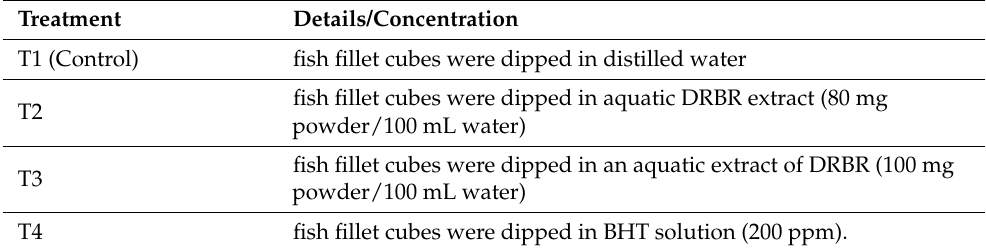
Table 1. Treatments and their concentrations.